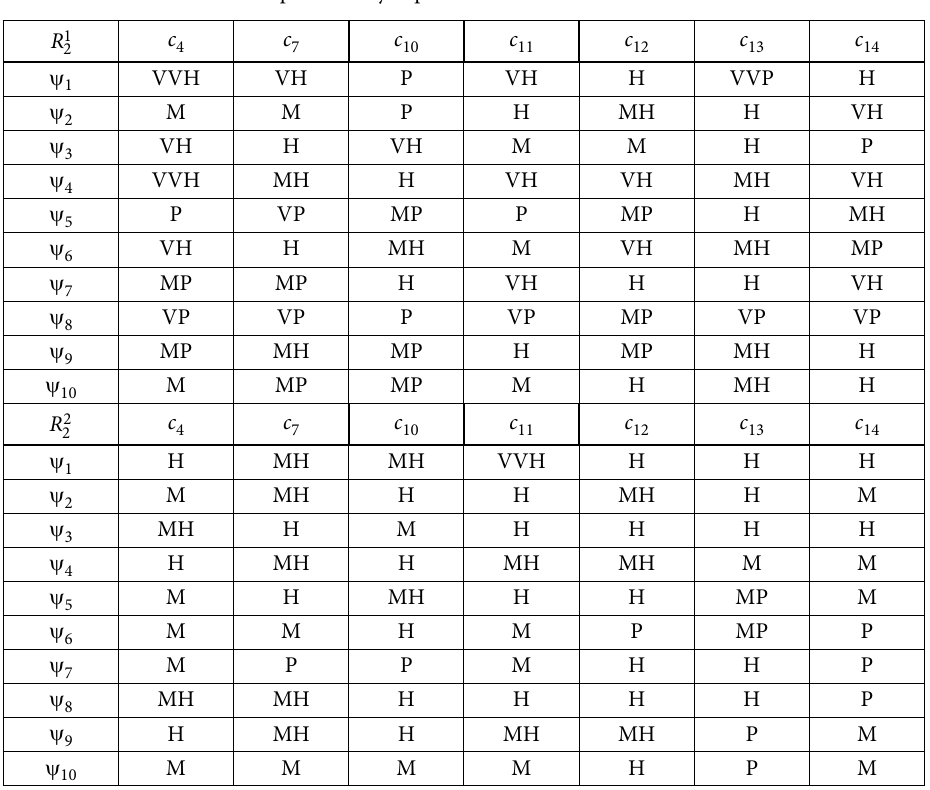
Table 5. The evaluation values provided by